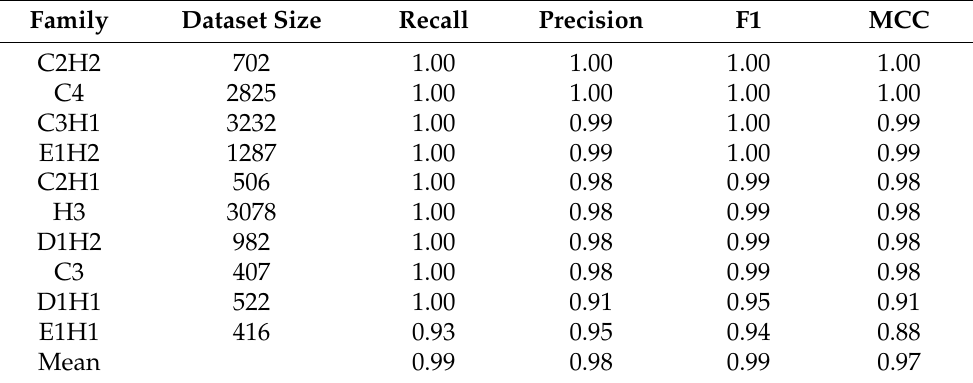
Table 1. Results for structure models, sorted by Matthews Correlation Coefficient (MCC). The two- residue families’ performance was lower than the others as there are essentially just the measurements between two centres to perform the classification, but still scored relatively highly. Four-residue sites in particular were found to have very high performance.